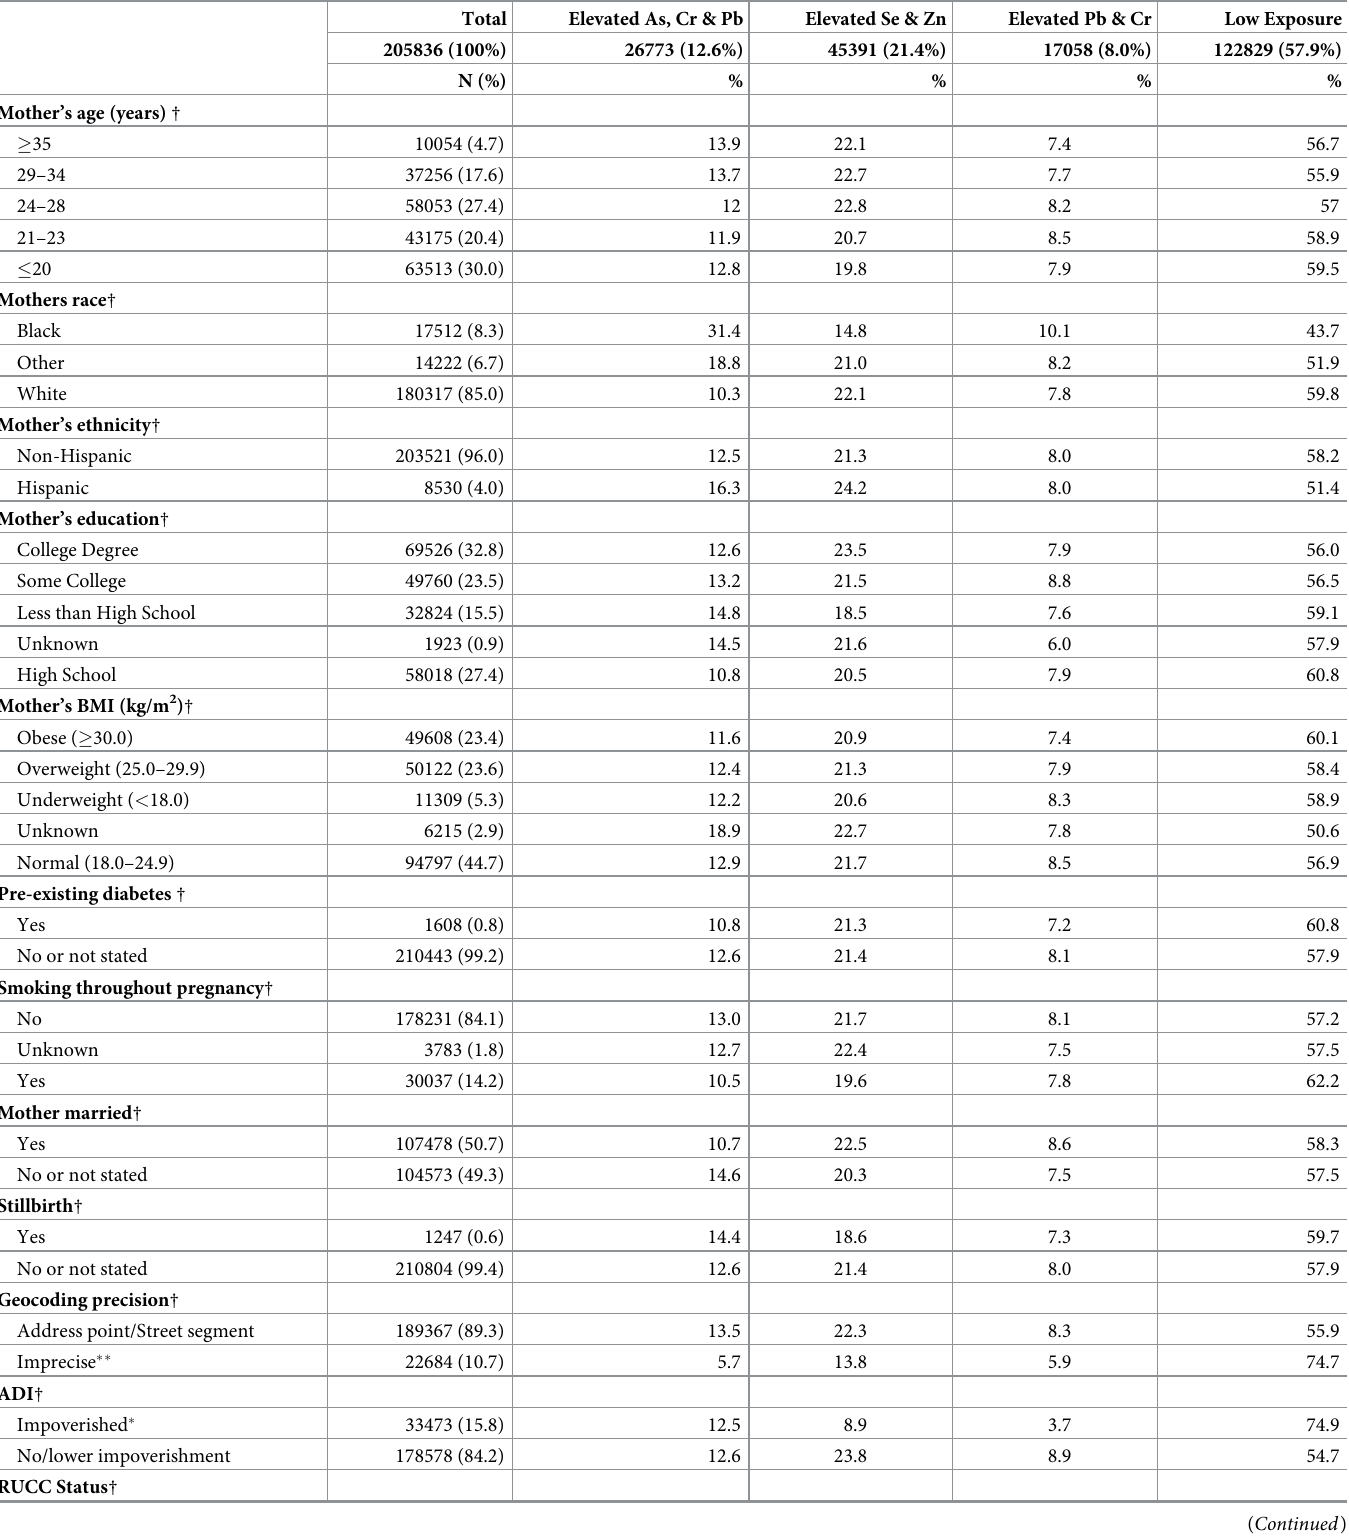
Table 2. Demographic characteristics summary by latent metal class and the total population of primiparous mothers